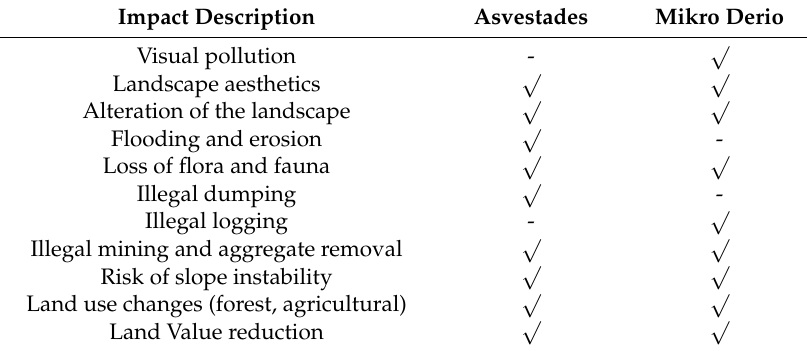
Table 1. Pivot table impact presentation of the study of the abandoned quarries.